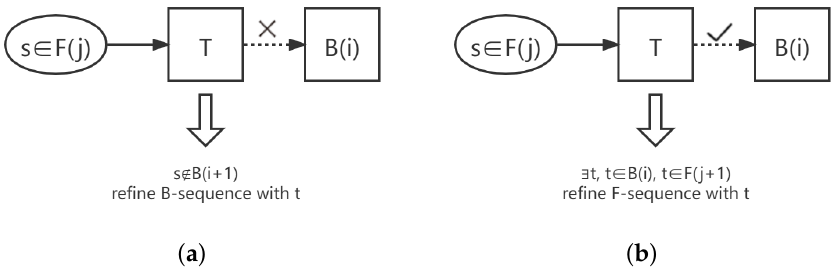
Figure 1. The schema to refine elements in the B- and F-sequences. This figure is better viewed online. ( a ) The schema to update elements in the B-sequence. ( b ) The schema to refine elements in the